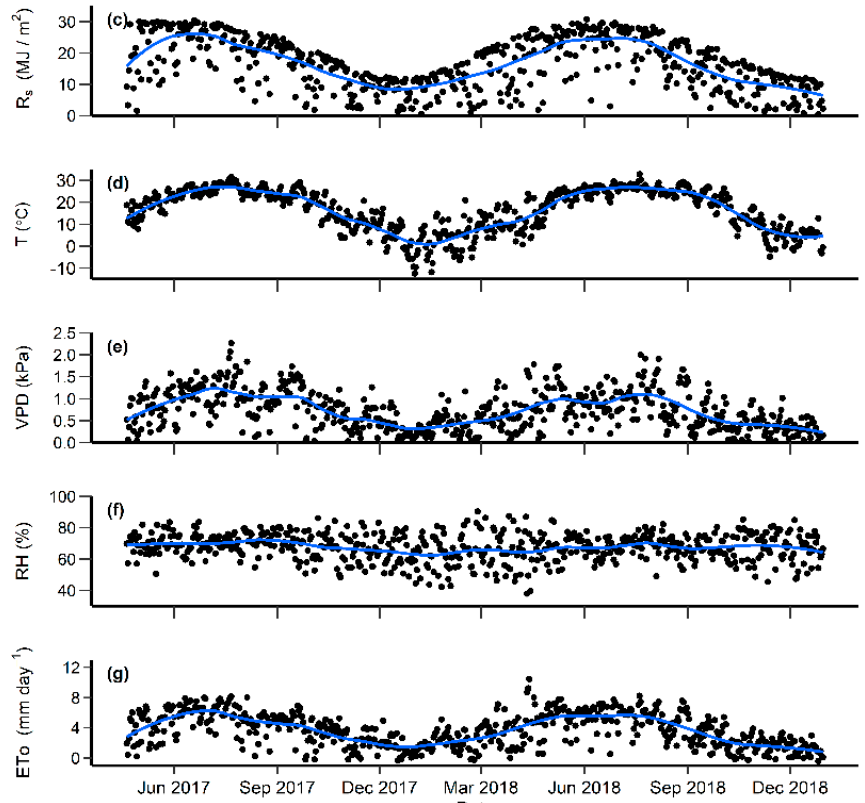
Figure 2. Daily precipitation (P) ( a ), soil water content ( θ ) from 0–10, 10–30, 30–60 cm ( b ), solar radiation (R s ) ( c ), temperature (T) ( d ), vapor pressure deficit (VPD) ( e ), relative humidity (RH) ( f ), and reference evapotranspiration (ETo) ( g ), from May 2017 to December 2018. The blue line is the locally weighted